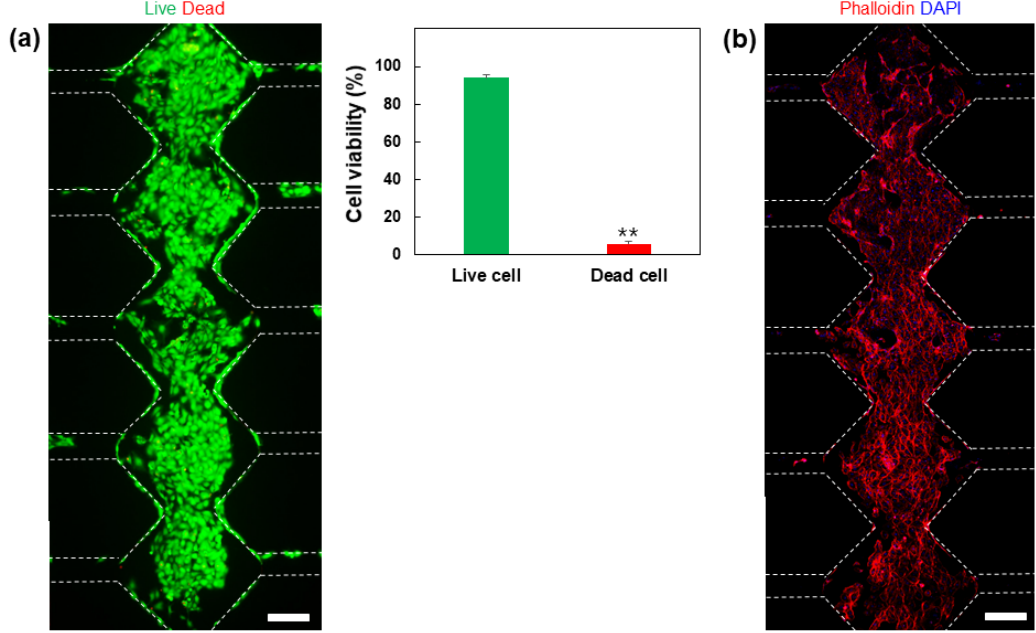
Figure 4. Biocompatibility analysis of the conductive GelMA–collagen–AgNW blended hydrogel. Live (green)/dead (red) fluorescence image of the human umbilical vein endothelial cells (HUVECs) cultured within the conductive GelMA–collagen–AgNW blended hydrogel (** p < 0.01) ( a ), and the confocal microscopy image of the HUVECs encapsulated within the conductive GelMA–collagen–AgNW blended hydrogel in the microfluidic device ( b ). The all scale bars are 100 µm.